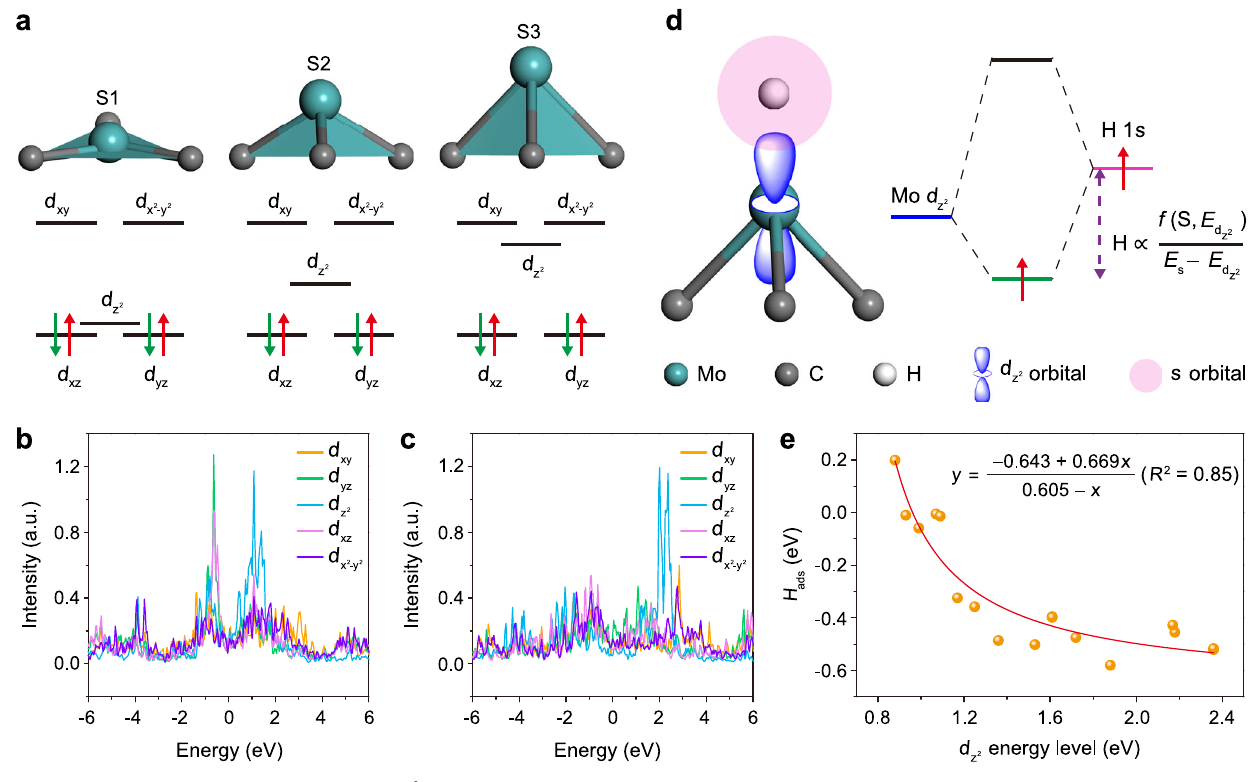
Fig. 6 | Relationship between HER activity and the d z 2 orbital energy level. a Structural models and relevant electronic states of Mo d orbital for MoC 3 con- fi gurations. S1: MoC 3 triangular plane, S2: intermediate height, S3: high height.